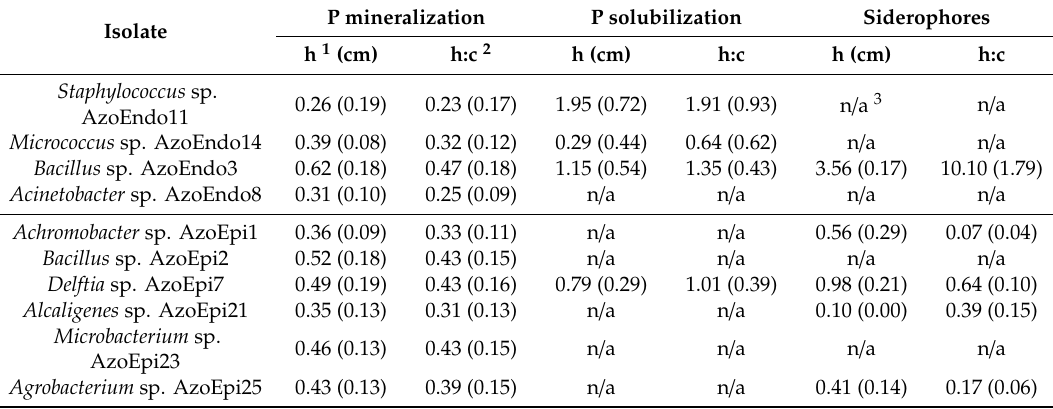
Table 5. Levels of IAA as well as cellulase and protease activities of studied isolates (means ± SD). P mineralization P solubilization Siderophores Isolate h 1 (cm) h:c